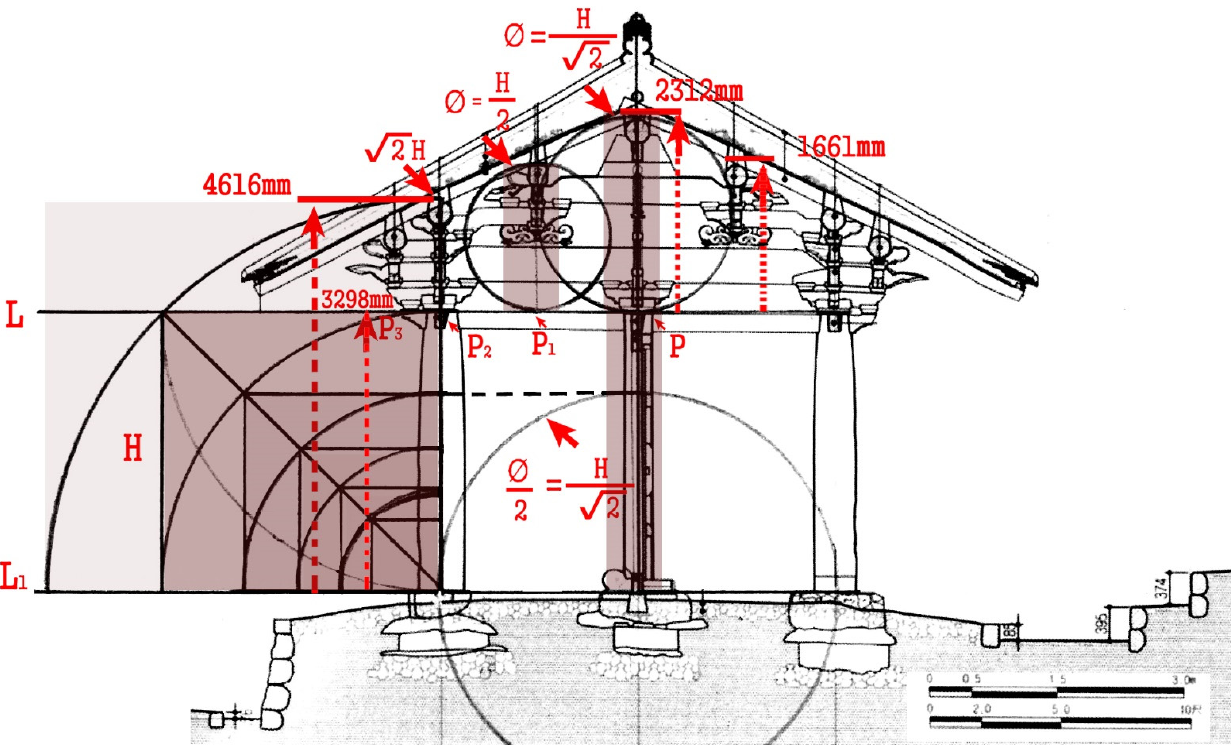
Figure 16. Sammun Gate of Imyeonggwan Guesthouse. Proportional analysis of the sectional elevation (H = eave column height, Ø = circle diameter), Adapted from CHA (2004, p. 442).